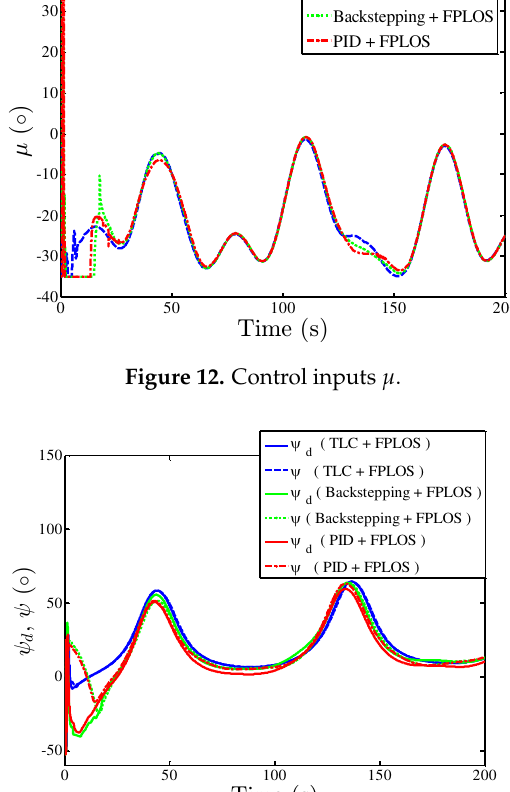
Figure 13. Guidance heading ψ d and heading ψ